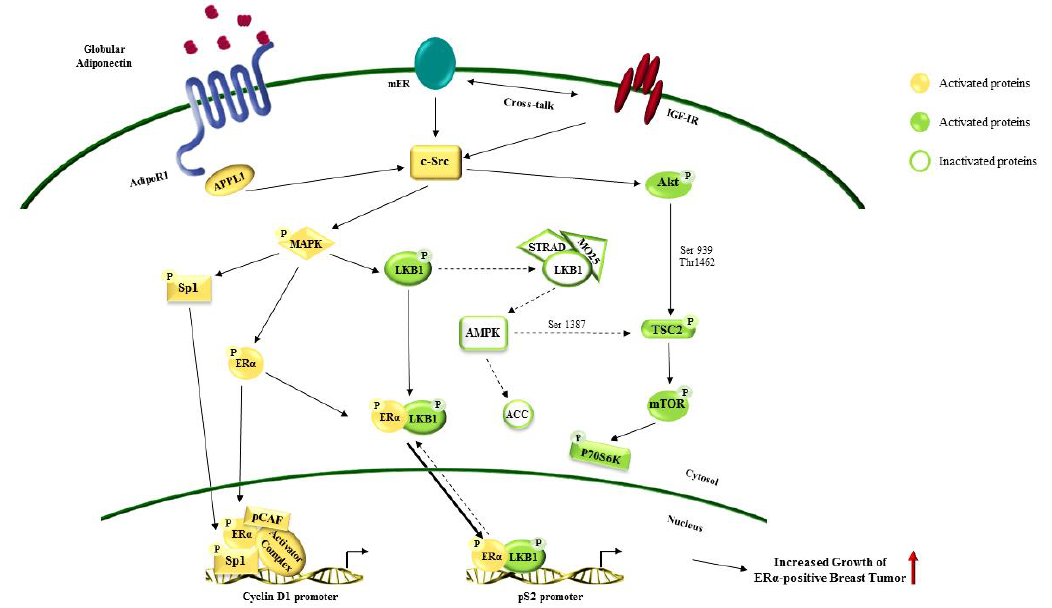
Figure 3. Effects of adiponectin in estrogen receptor alpha (ERα)-positive breast cancer growth. Globular adiponectin binds its receptor AdipoR1 on breast cancer cell surface. Adiponectin/AdipoR1 cross-talk with ERα and insulin growth factor 1 receptor (IGF1R) activating several downstream pathways involved in sustaining breast cancer cell growth and progression. The red ↑ Indicates increased growth of ERα-positive breast cancer. Dotted arrows show signaling inhibition. Solid arrows marks signaling activation. The arrows from cytosol to nucleus and vice versa indicate protein translocation. Solid arrows show a greater localization of the proteins in the nucleus. Dotted arrows mark a cytosolic localization.